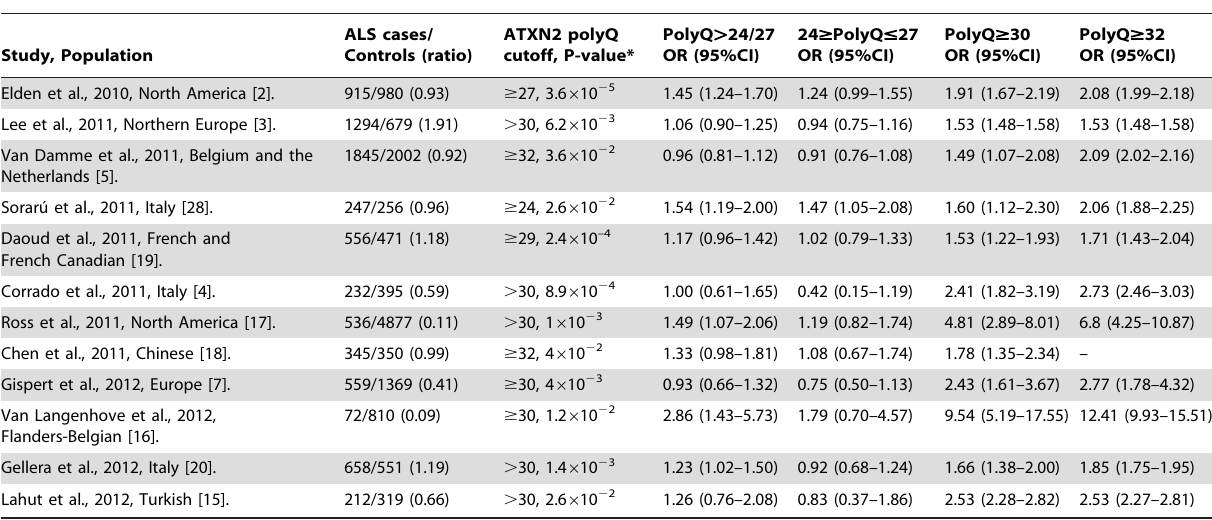
Table 3 . Meta-analysis for case-controls series for ATXIN-2 polyQ intermediate length and ALS.